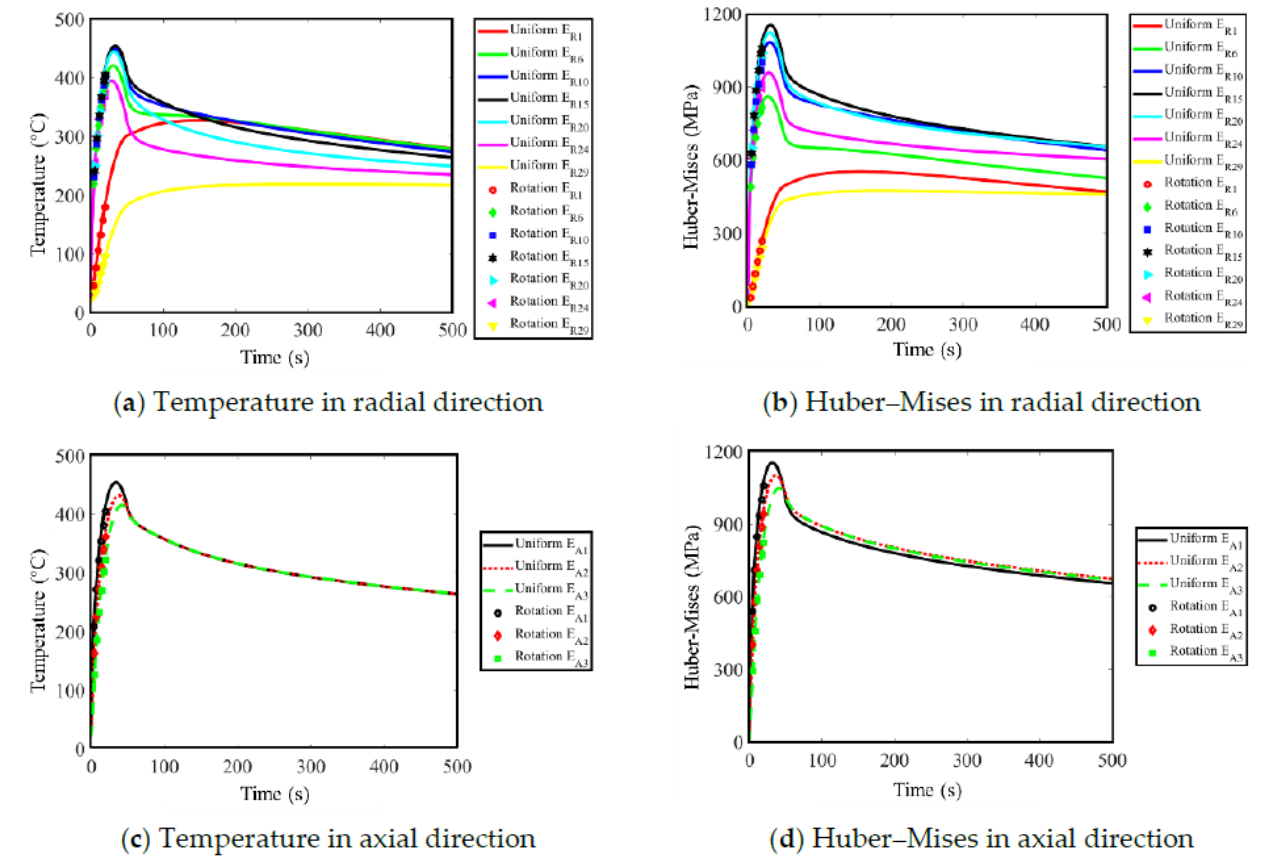
Figure 6. Comparison between the results with uniform loading and rotating loading.